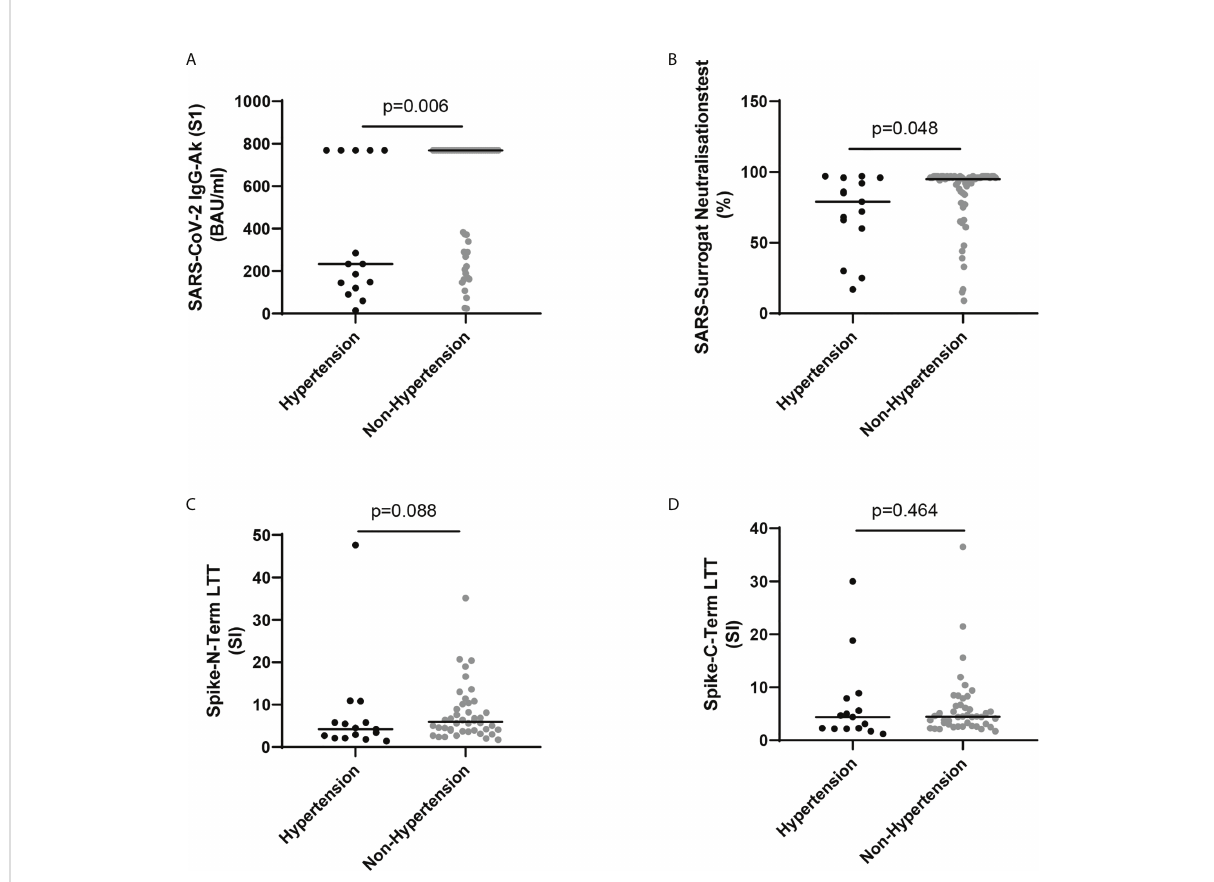
TABLE 5 Wild bootstrapping multivariate regression of hypertension with humoral and cellular response parameters as dependent variables in infected health care workers. Cellular and humoral response parameters B Bias Std. Error Sig.